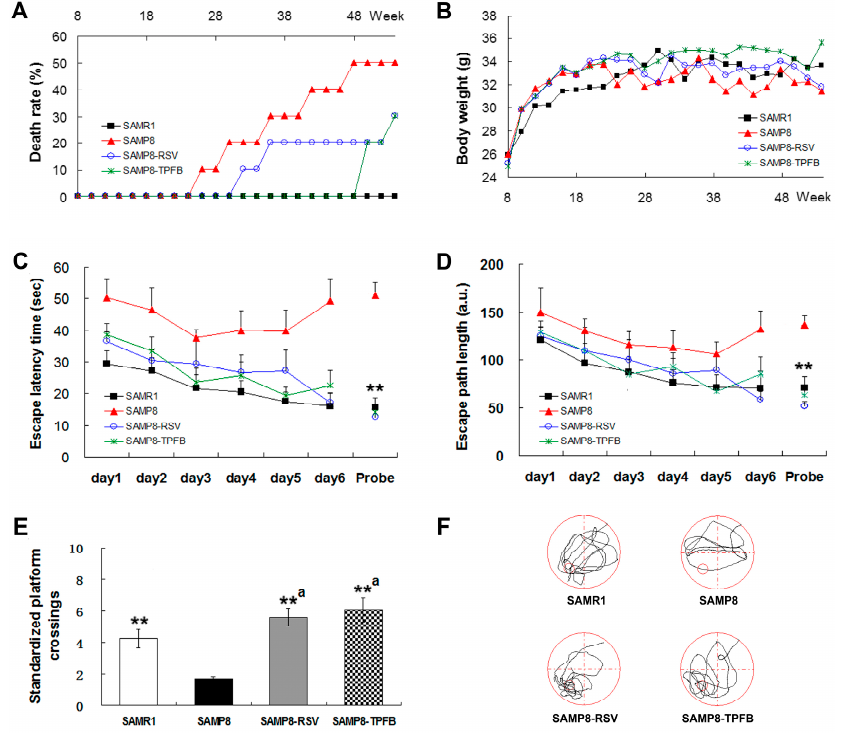
Figure 2. Dietary TPFB significantly improved the spatial learning and memory performance of SAMP8 mice. During the experiment, the SAMP8 group showed increased death rate whereas no death was observed in SAMR1 mice. Both TPFB (50 mg/kg·day) and resveratrol (RSV, 150 mg/kg·day) groups showed ( A ) lower death rates and ( B ) slightly higher body weights. At the age of 12 months, SAMP8 mice ( n = 5) displayed behavioral impairments in Morris water maze (MWM) test with significantly ( C ) longer escape latency time and ( D ) longer escape path length than SAMR1 ( n = 10) during training and probe trials, and they accomplished the probe test with ( E ) fewer standardized platform crossings and ( F ) abnormal path traces. Nine-month treatment by TPFB (50 mg/kg·day, n = 7) or resveratrol (RSV, 150 mg/kg·day, n = 7) significantly improved above parameters of SAMP8 to near-normal levels of SAMR1. Data are expressed as mean ± SEM. ** p < 0.01 vs. SAMP8 group; a Non-significant vs. SAMR1